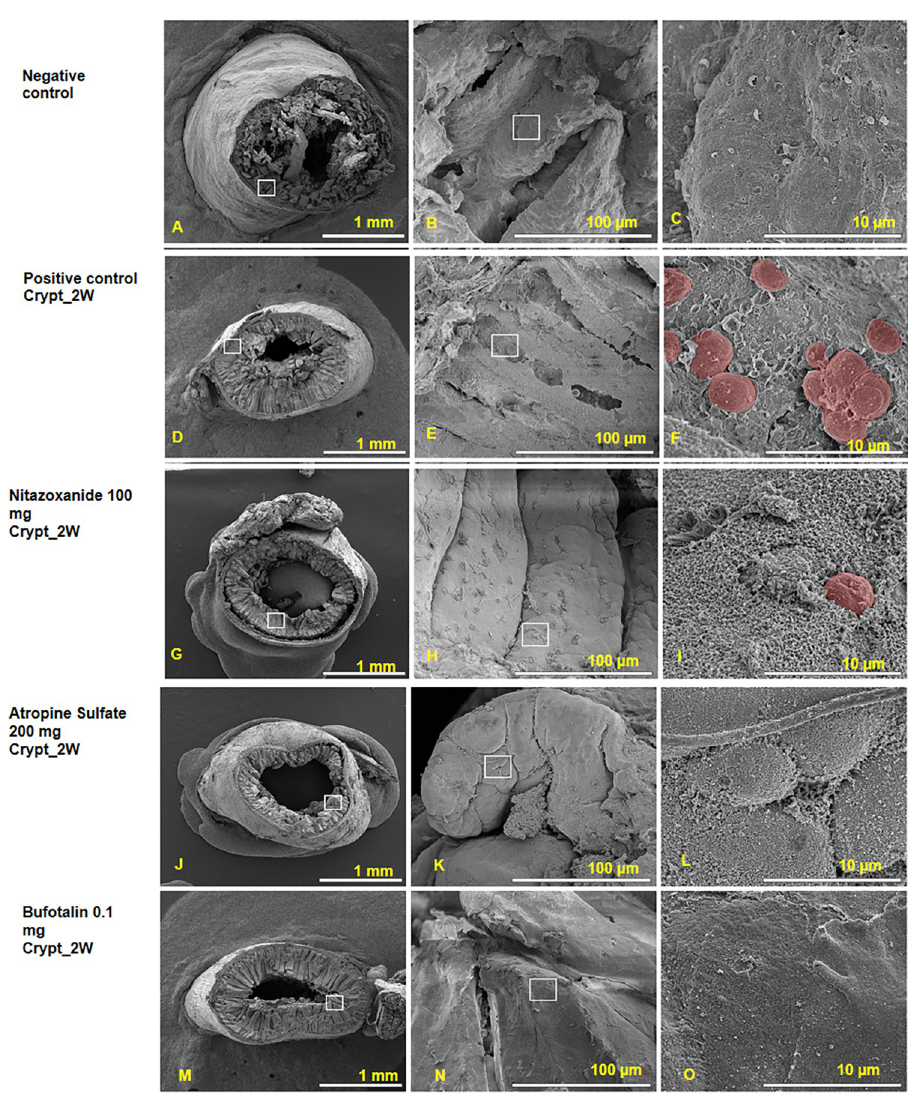
Fig 6. Scanning electron microscopic (SEM) findings the compound’s effects of ileum tissues. The SEM images of intestinal ileum tissue of different groups of mice infected with C . parvum and treated with hit compounds, as well as the negative (A-C) and positive (D-F) control groups, and comparative drug (nitazaxonide)-treated group (G-I). Atropine sulfate- (J-L) and bufotalin- (M-O) treated mice showed no abnormalities or visible parasites in the intestine. The SEM shows the intracellular structures as well as the surface of C . parvum attached to the host cells. These compounds had no adverse effects on the ileum